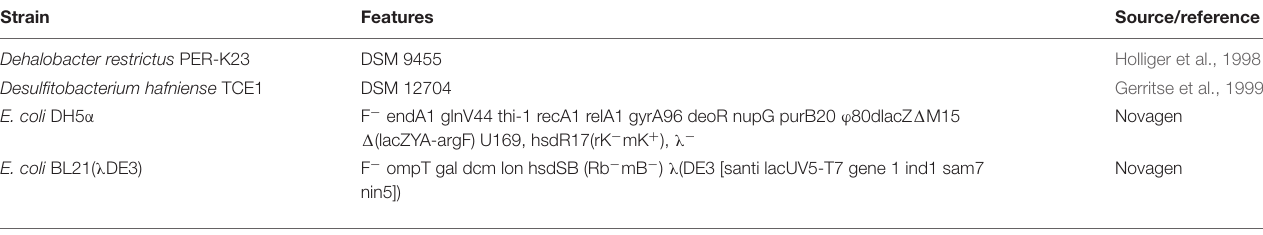
TABLE 2 | Plasmids used in this study.